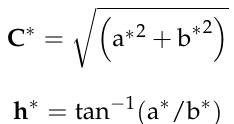
Figure 1. Fresh burgers covered with oval clear plastic cellophane discs.